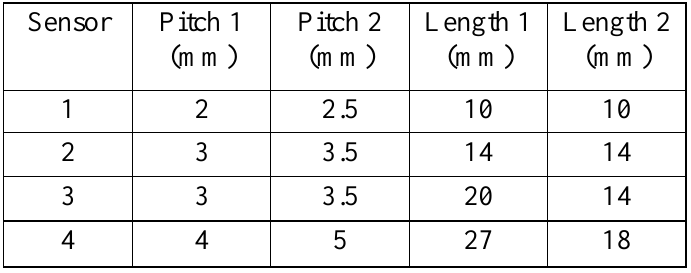
Table 2. Mesh sensor parameters.